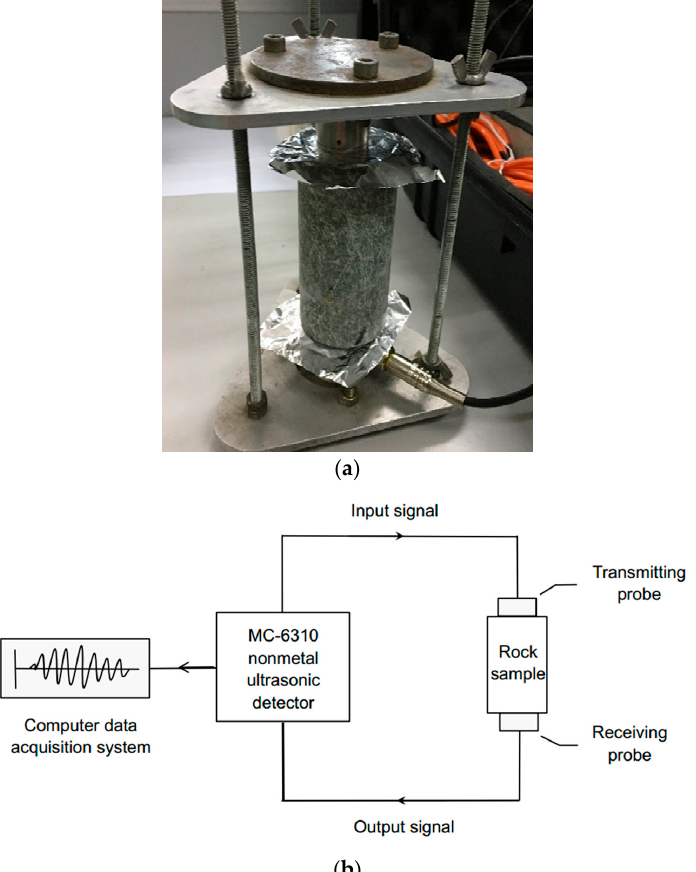
Figure 3. Acoustic wave testing. ( a ) experimental process of wave velocity test in rock; and ( b ) schematic diagram of the acoustic wave test.